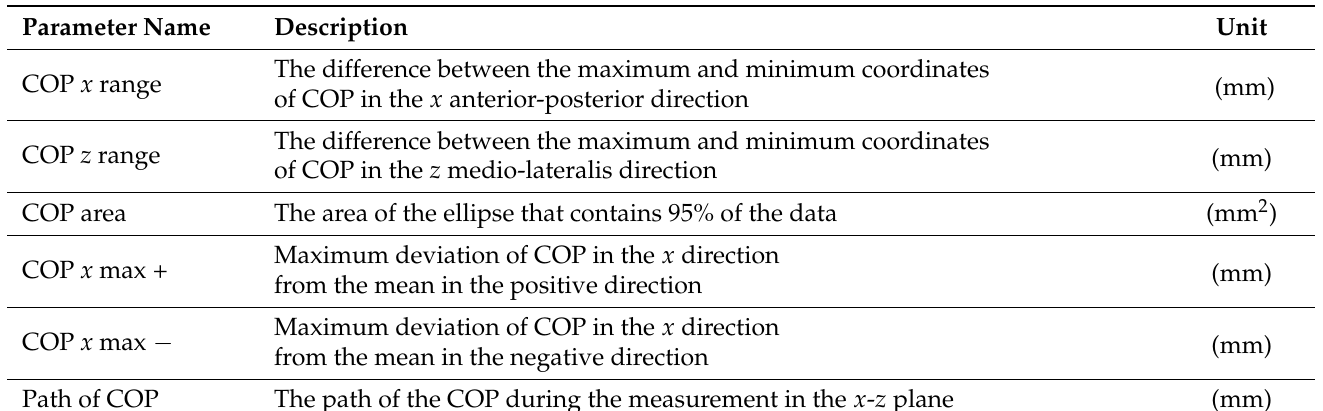
Table 2. Examined COP